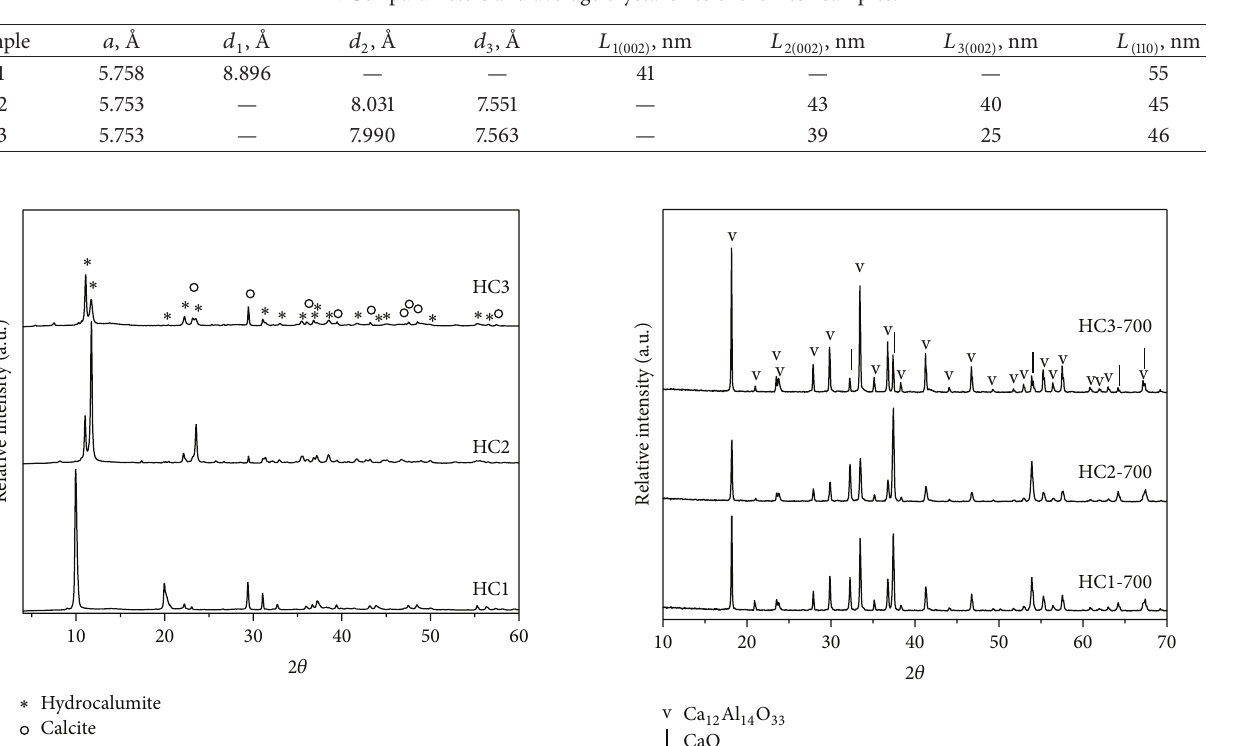
Table 1: Cell parameters and average crystal sizes of the fresh samples.